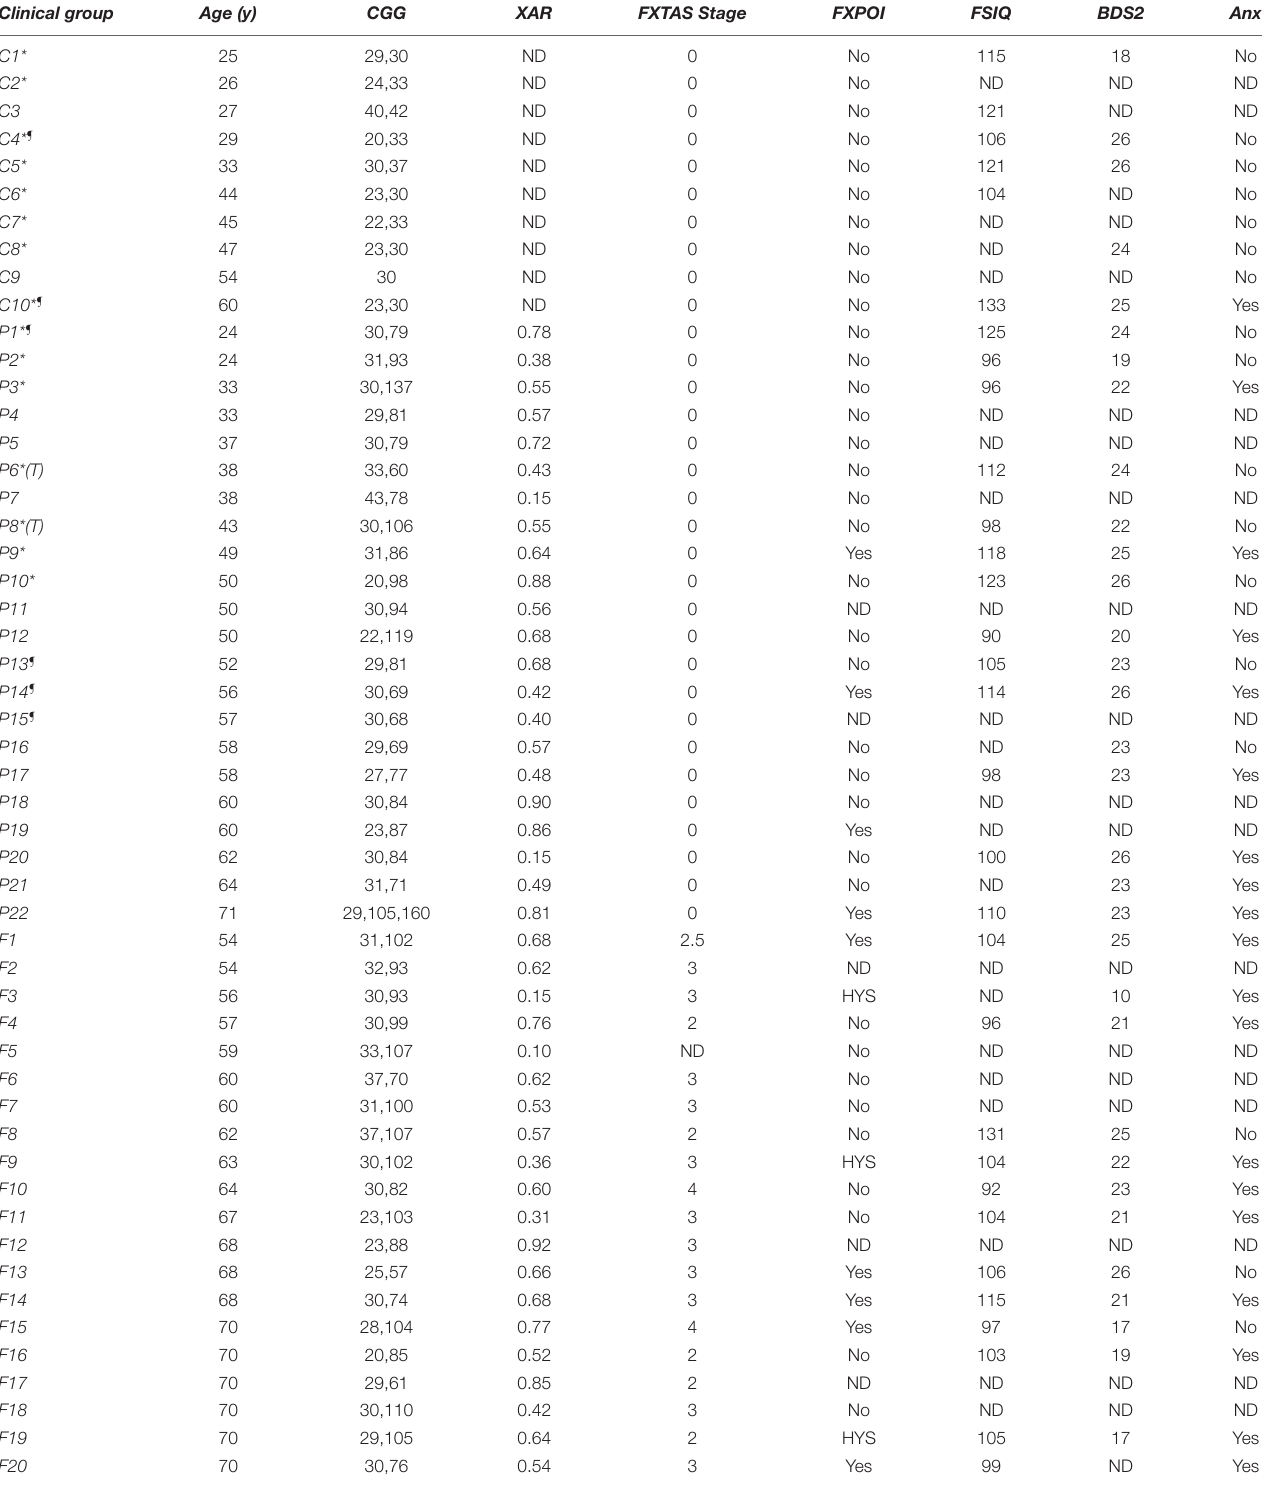
TABLE 1 | Demographic and clinical data of the women included in this study. Clinical